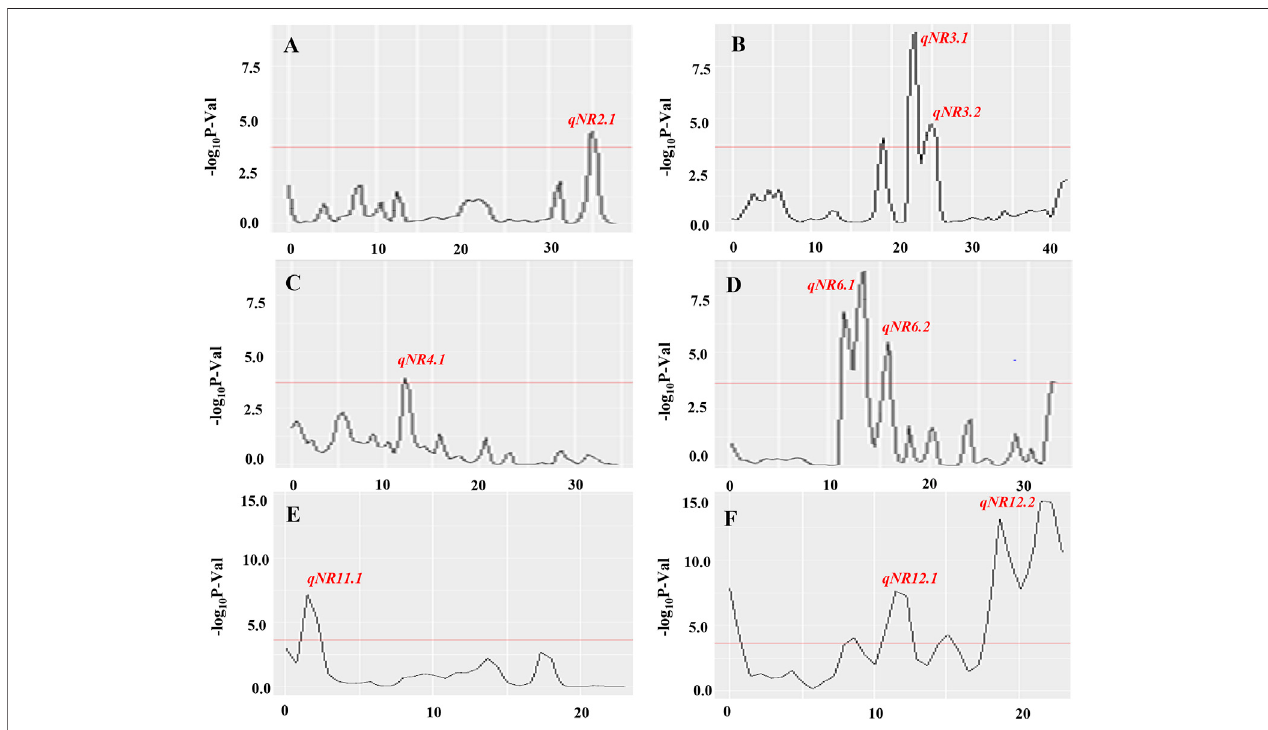
FIGURE3| Quantitativetraitlociforroot-knotnematoderesistanceidenti fi edonchromosomes2 (A) ,3 (B) ,4 (C) ,6 (D) ,11 (E) ,and12 (F) usingBSA-seqanalysis. Distribution of – log10 p -value was calculated within a 1.0-Mb sliding window using tricube-smoothed kernel. The Y -axis represents – log 10 p -values and the X -axis representsthepositionofchromosomesinMb.Thered linerepresents thesigni fi cancethresholdforFDR=0.01,andthegenomicregionwhere – log10 p -valuecrosses the threshold was considered as signi fi cant QTL. Out of 12 chromosomes, signi fi cant QTLs identi fi ed on six chromosomes are shown.